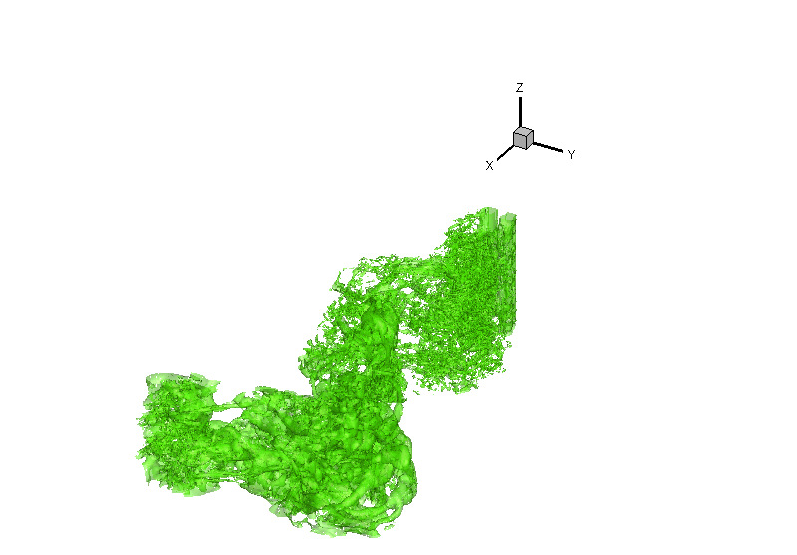
Figure 3. WA-LES of square-cylinder flow: spanwise vorticity contours ( left ) and computational mesh ( right ) in the planes Z / H = − 1.2, 0, and 1.2 at a given time instant in the near wake.